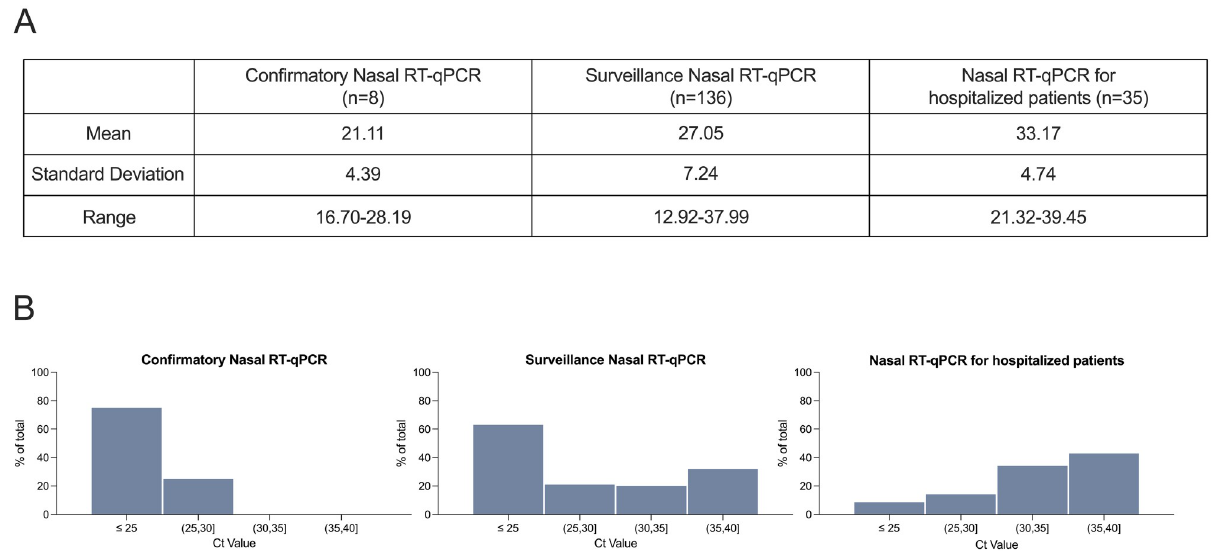
Fig 7. Nasal Ct distributions in surveillance population and hospitalized patient population. (A) Mean, standard deviation, and range of Ct values and (B) frequency distributions of Ct values for confirmatory nasal RT-qPCR tests after an individual tested positive with LAMP (n = 8), for individuals who tested positive as part of Rice University’s surveillance testing program with the testing provider who conducted confirmatory RT-qPCR tests (n = 136), and for all hospitalized patients who tested positive by nasal RT-qPCR (n = 35).